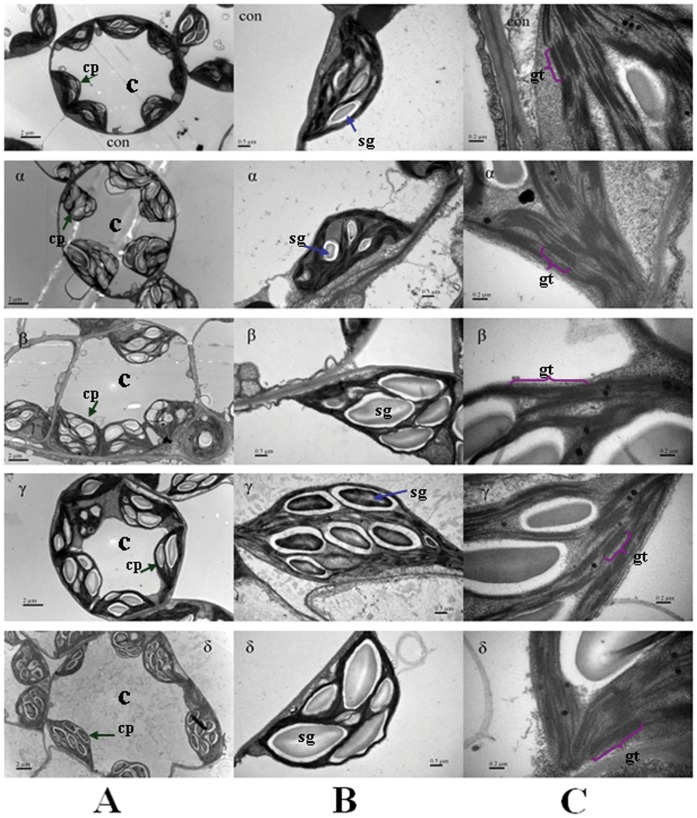
The substructure of Arabidopsis thaliana leaves treated by α-, β-, γ- and δ-HCH.(A) Mesophyll cell structure; (B) Chloroplast; and (C) Thylakoid structure. The Chloroplast (cp), starch granules (sg) and granal thylakoid (gt) are marked with colorful arrows respectively.